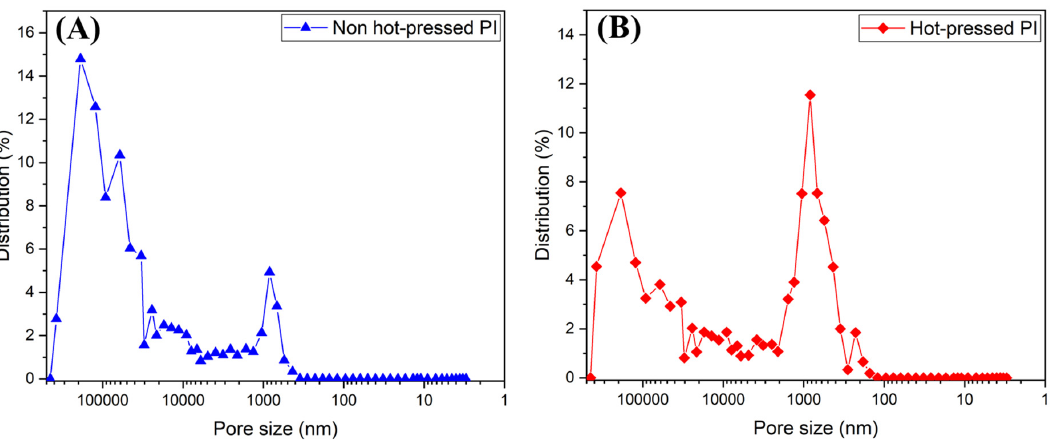
Figure 6. Pore size–distribution curves of ( A ) raw BI-PI membrane and ( B ) hot-pressed BI-PI mem- brane.